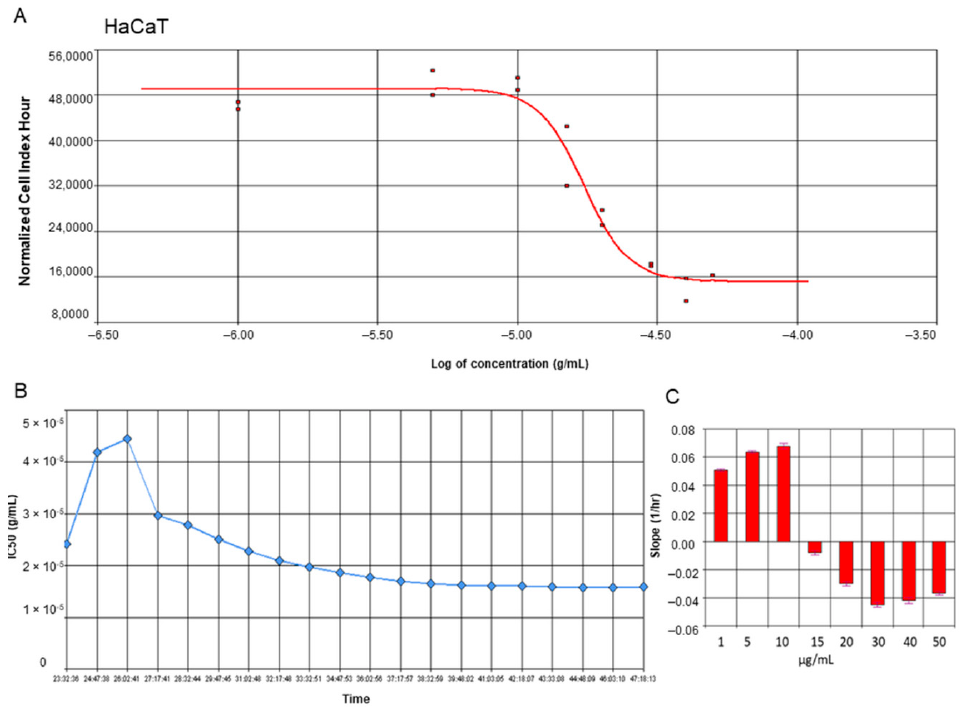
Figure 3. RTCA profiles of cell index ( A ), IC 50 values ( B ), and slope of changes ( C ) in cytotoxic effect of yamogenin on the HaCaT cells. The cells were incubated with the compound for 24 h, and nor- malized cell index vs. concentration of yamogenin was calculated by RTCA system ( A ). The IC 50 values of yamogenin were obtained at every time point of the experiment (every 30 min) ( B ). The slope of changes in cytotoxic effect of yamogenin was calculated for every used concentration of the compound during the experiment ( C ). The results were obtained in three independent exper- iments. Error bars represent standard deviations.